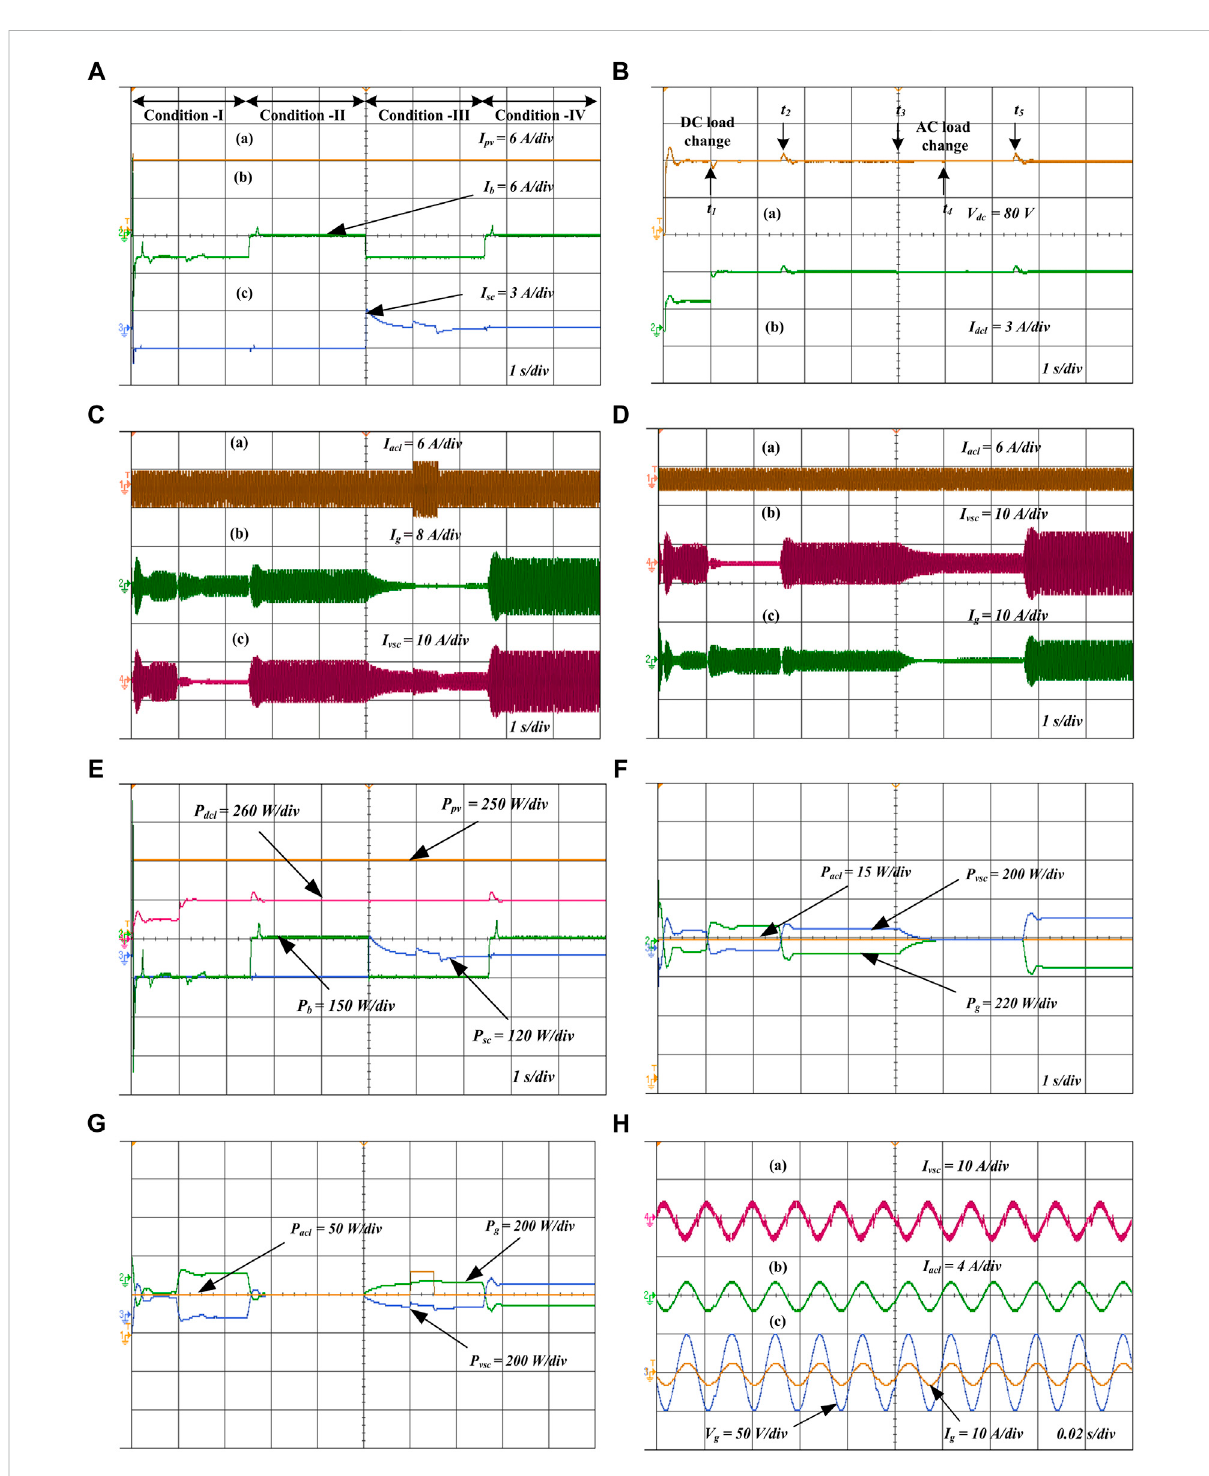
FIGURE 17 (A) HIL results: (a) PV, (b) BS, and (c) SC currents. (B) HIL results: (a) DC-link voltage, (b) DC load current. (C) HIL results: (a) AC load, (b) grid, and (c) VSC currents. (D) HIL results: (a) constant AC load, (b) VSC, and (c) grid currents. (E) HIL power results for PV, BS, SC, and DC load under EPM operation. (F) HILpowerresultsforVSC,constantACloadandgrid. (G) HILpowerresultsforVSC,ACload,andgrid. (H) HILresults:(a)VSCcurrent,(b) AC load current, (c) grid current and